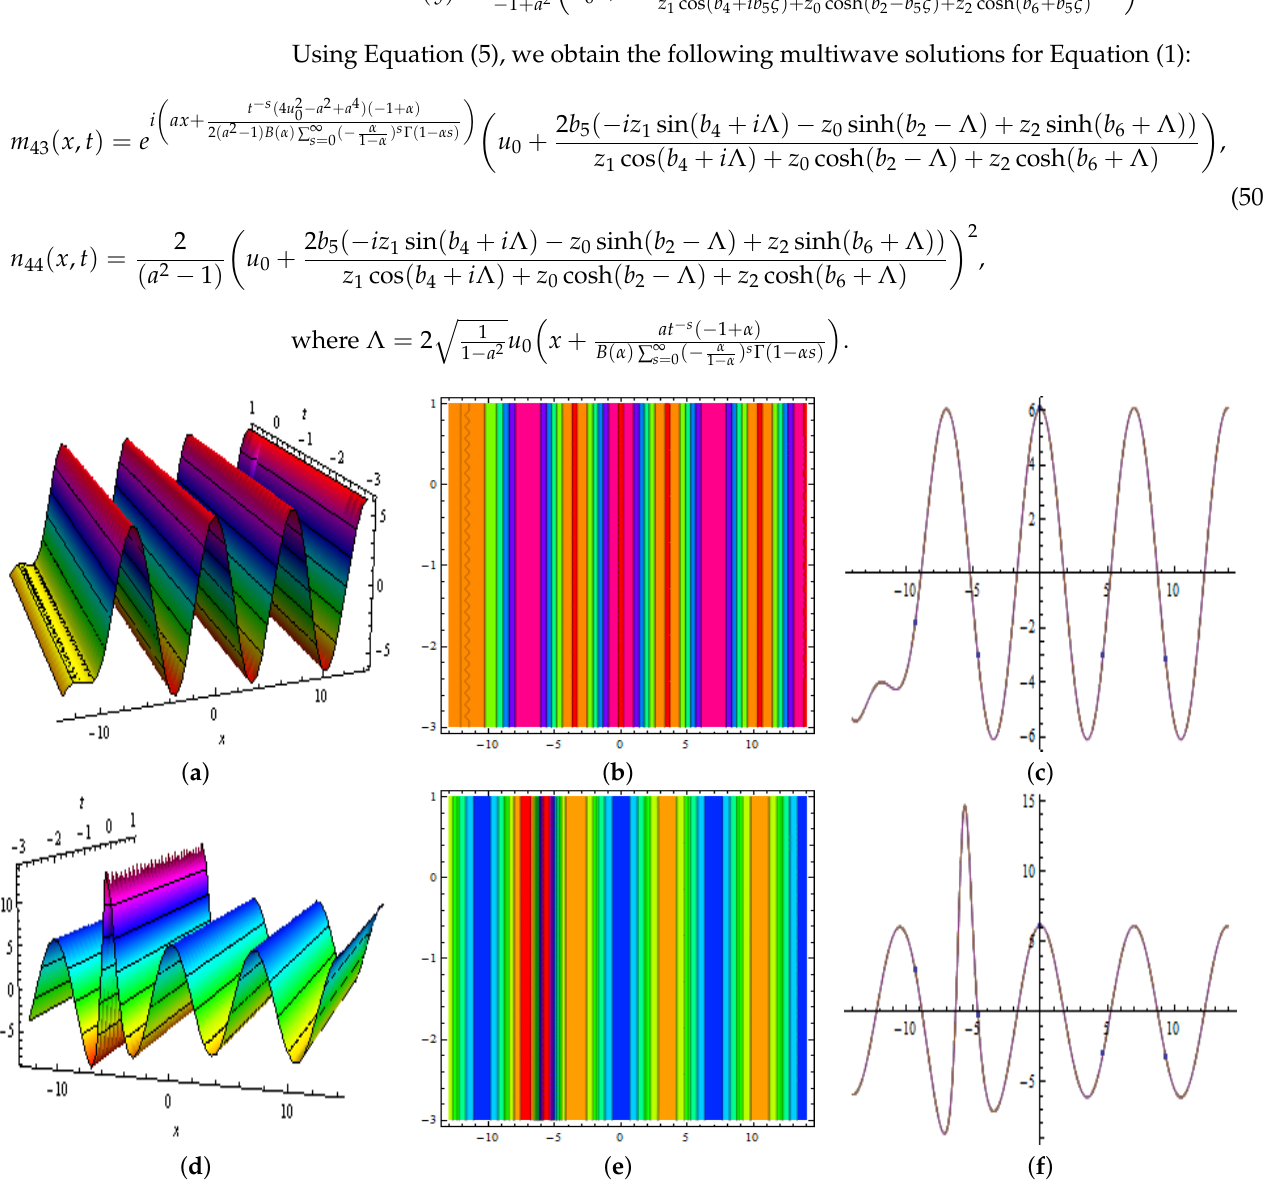
Figure 12. Showed three-dimensions in ( a ); contour in ( b ) and two-dimensions in ( c ), Graphical representation of m 43 ( x , t ) in Equation (50), for a = 0.9, u 0 = 0.1, b 2 = − 5, b 4 = 5, b 5 = 3, z 0 = − 2, z 1 = 1, z 2 = 2, α = 0.9,